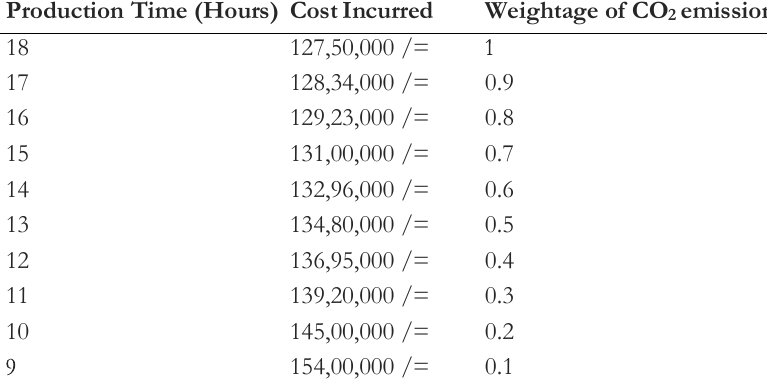
Table 2. Carbon di-oxide emission data.